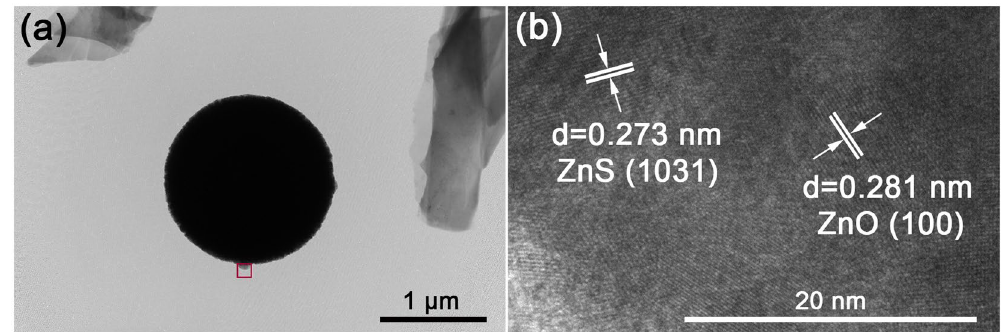
Figure 5. ( a ) TEM image and ( b ) HRTEM image of the nanospheres in NZZN-4 mmol. The crystalline details in red square area in ( a ) are described in ( b